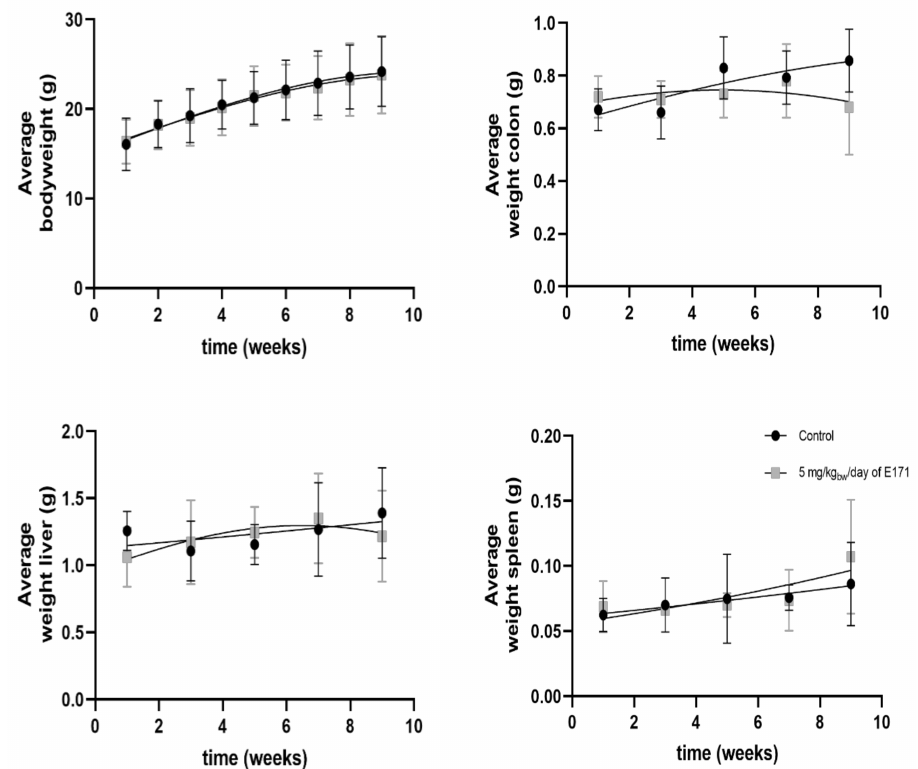
Figure 3. Average bodyweight and organ weight of Tg mice following intragastric exposure to 5 mg/kg bw /day of E171 over time (n = 78). One mouse was euthanized ahead of the schedule due to rectal prolapse. A second mouse from the control group was ruled as an outlier due to severe tumor formation. These mice were not included in the graphs. After euthanasia, colon, liver, and spleen were weighed. The black data series corresponds to the control mice exposed to sterile water and the grey data series is attributed to the mice exposed to 5 mg/kg bw /day of E171 via intragastric administration. Data is presented as the mean +/ − standard deviation of each timepoint.